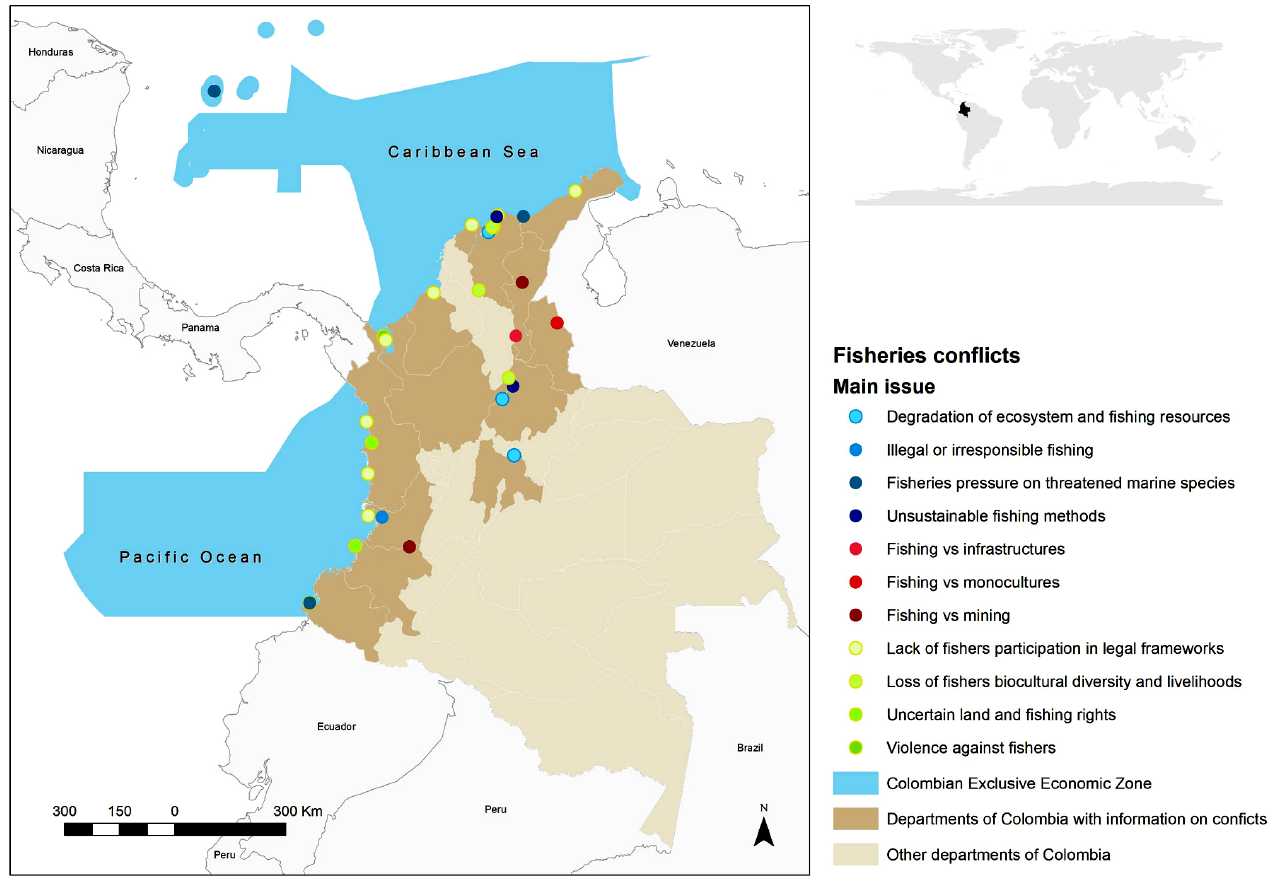
Fig. 1 . Location of the conflicts reported in the films. Source: Questionnaire to film producers and content of the